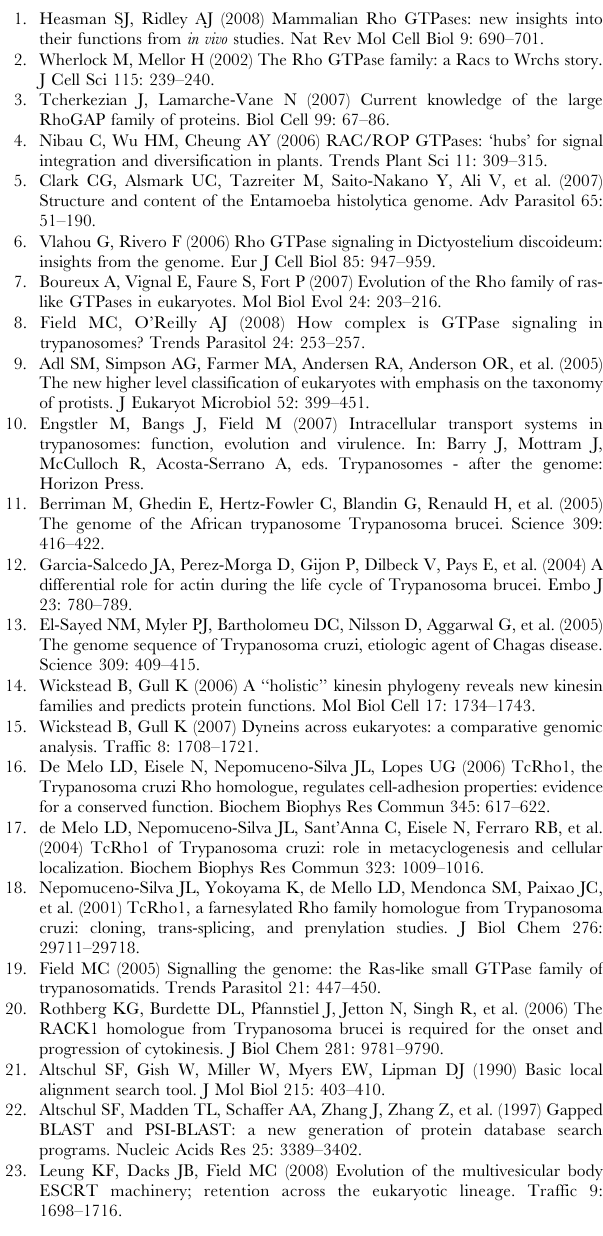
Figure S5 Actin localizes to the division plane between daughter nuclei in mitotic PCF cells. In cells expressing actin-GFP, a thin bridge of actin was observed at the division plane between dividing nuclei (white arrows) in mitotic cells (2K1N and 2K2N). This band of actin appeared to progressively thicken as nuclei divided. Such a structure was not observed in non-mitotic (1K1N) cells. Table S1 Accession numbers for sequences used in this study. Top: Rho and Rho-related proteins included in recon- struction in Figure 1. Middle: OCRL proteins included in the analysis of OCRL phylogeny in Figure S2. Lower: TbRHP syntenic genes and orthologues from trypanosomes and Leishmania